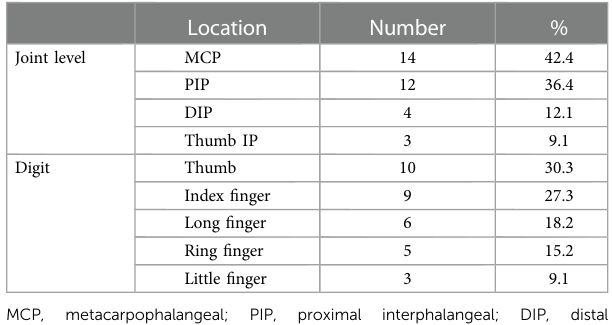
TABLE 2 Digit and joint level locations of 26 previously reported calci fi c tendinitis